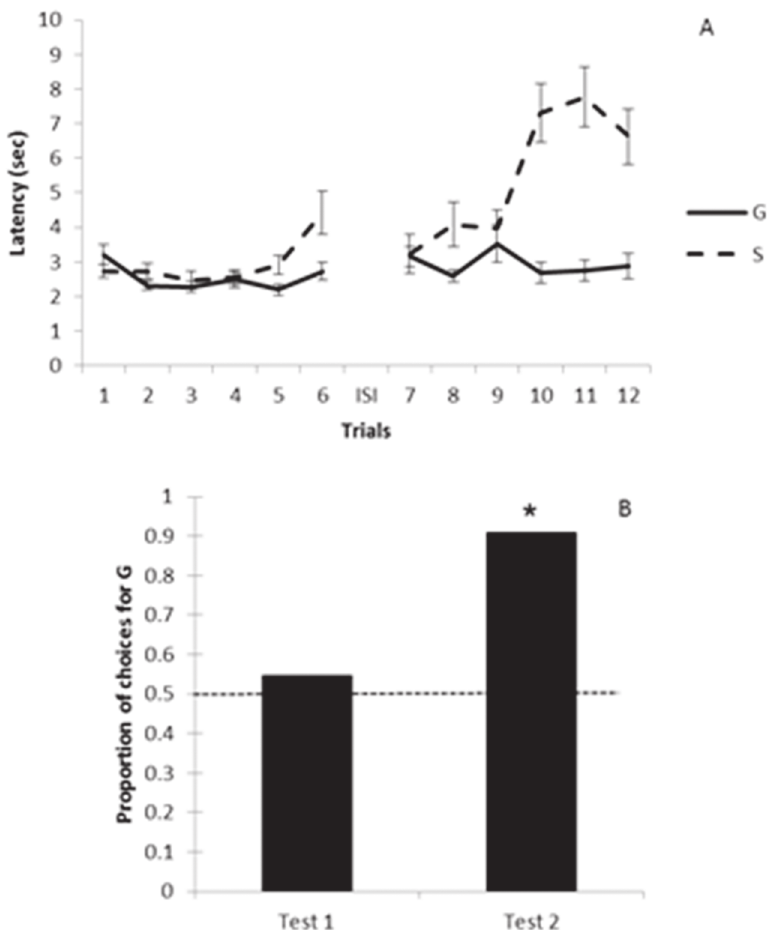
Fig 3. (A) Study 1: Mean latency as a function of trials with the generous and selfish experimenters. The dashed line represents the latency to approach the selfish (S) experimenter, whereas the full line represents the latency to approach the generous (G) experimenter. ISI: inter-session interval. Error bars denote ± 1 sem. (B) Study 1: Proportion of choices for the generous (G) over the selfish (S) experimenter. The horizontal dashed line indicates the 0.50 chance level. * : p <